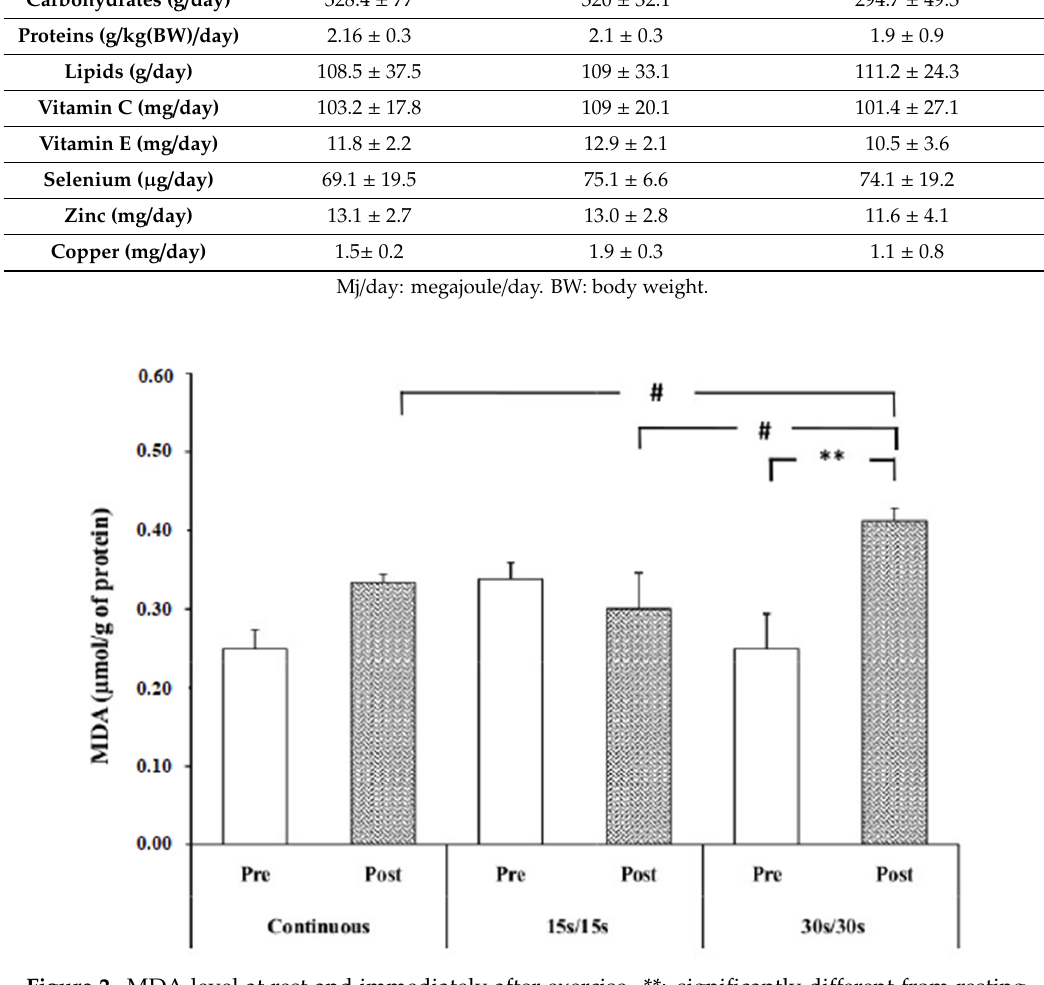
Figure 2. MDA level at rest and immediately after exercise. **: significantly di ff erent from resting values ( p < 0.01); #: significantly di ff erent from 30 / 30 intermittent exercise ( p <